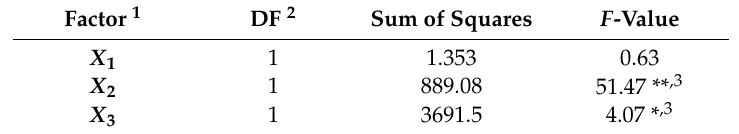
Table 2. Results of analysis of variance for C3G contents in the extracts of aronia.